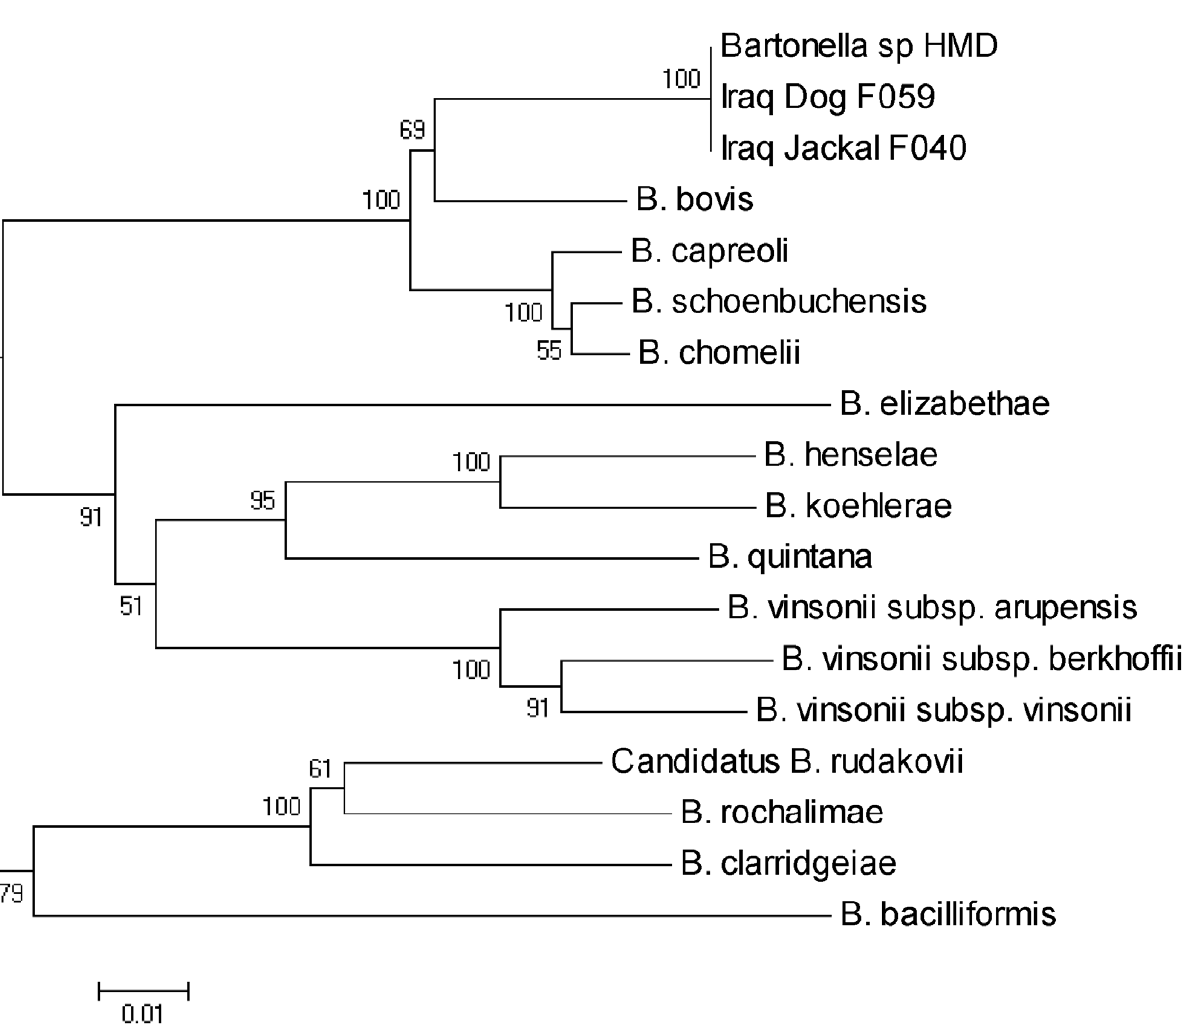
Figure 1. Phylogenetic tree of Candidatus B. merieuxii and other Bartonella species. The phylogenetic tree was based on concatenated sequences of two housekeeping genes (gltA and rpoB) and the 16S-23S rRNA intergenic spacer region and was constructed from 941 base-pair sequences, inferred using the Neighbor-Joining method, and 1000 replicates in the bootstrap test. Scale bar indicates 10 substitutions per nucleotide position.